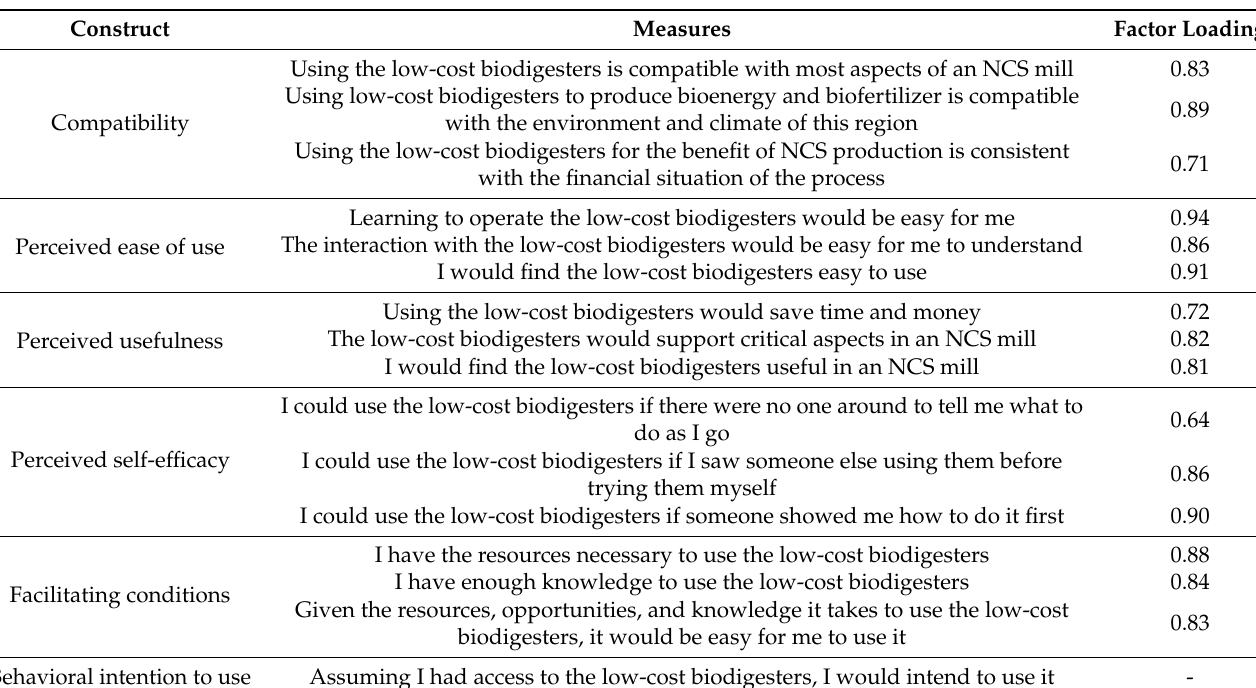
Table 3. Factor analysis between the constructs and the measurable